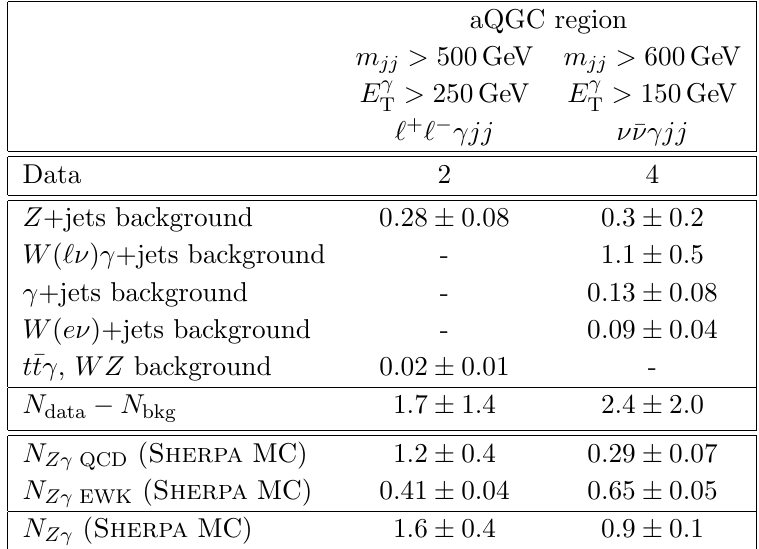
Table 3 . Summary of events observed in data and estimated composition of the background for the Z ( ‘‘ ) (cid:13)jj and Z ( (cid:23) (cid:22) (cid:23) ) (cid:13)jj production processes in the aQGC region. The last line corresponds to the sum of the two previous lines ( N Z(cid:13) QCD + N Z(cid:13) EWK ). The quoted uncertainty corresponds to the total statistical plus systematic uncertainty added in quadrature.